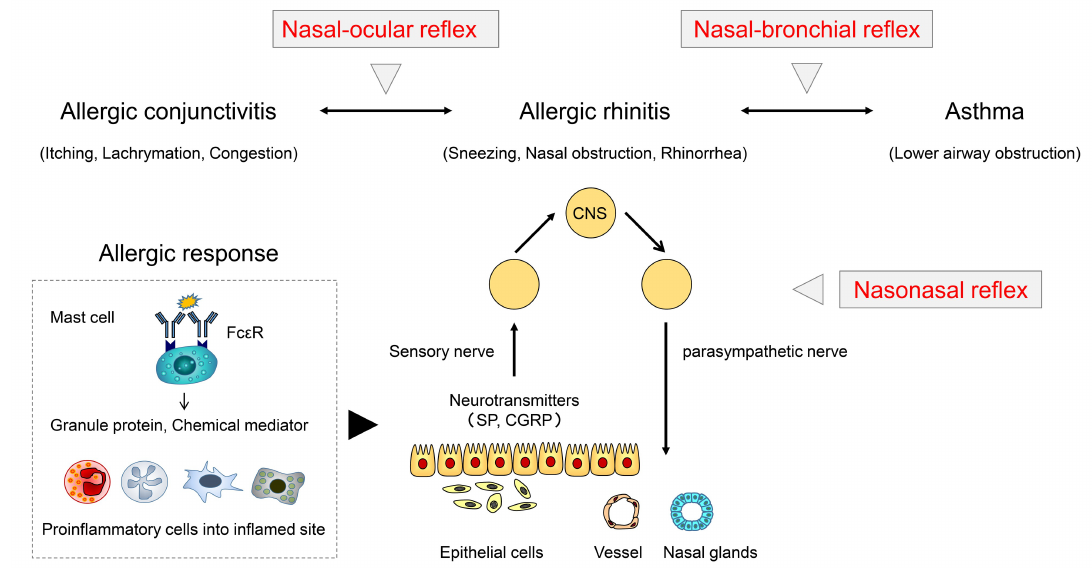
Figure 2. Neural pathway in allergic rhinitis; nasonasal reflex, nasal-ocular reflex, and nasal–bronchial reflex. CGRP, calcitonin gene-related peptide; SP, substance P; Fc ε R, Fc epsilon